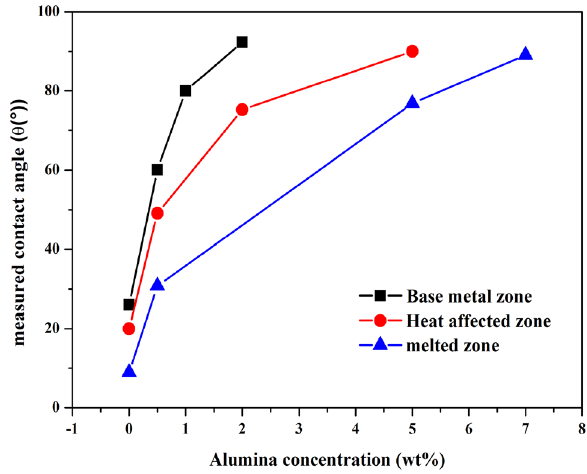
Figure 14. Evolution of contact angle values on the three studied zones without and with Epoxy/wt% Alumina coatings.